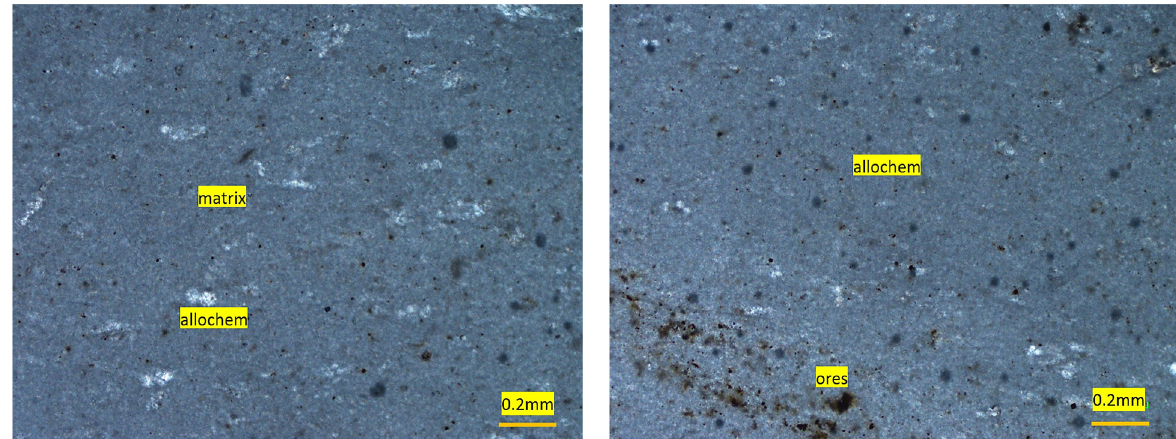
Figure 12. Photomicrographs of mudstone showing few allochems and lime-mud